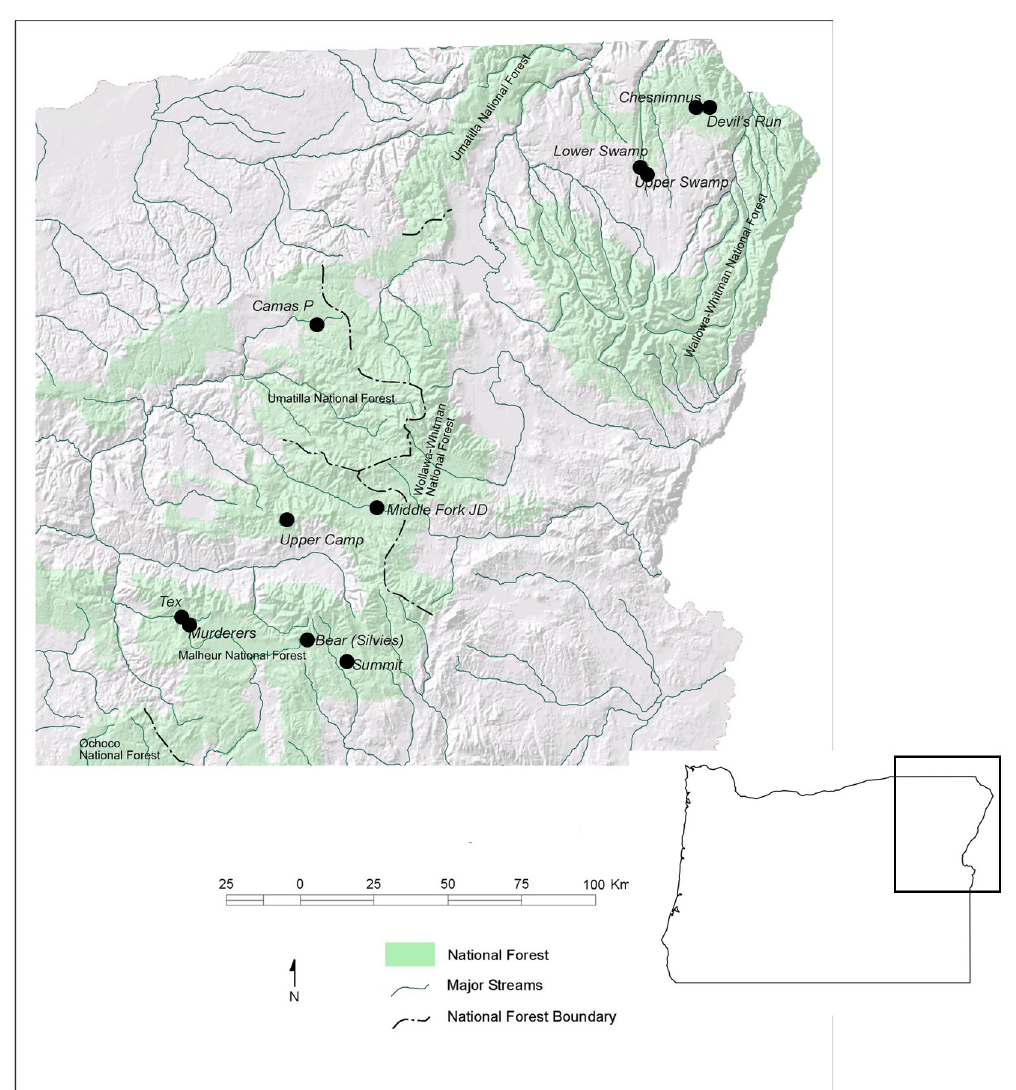
Fig 1. Location of the 11 study stream reaches selected for study in northeastern Oregon,